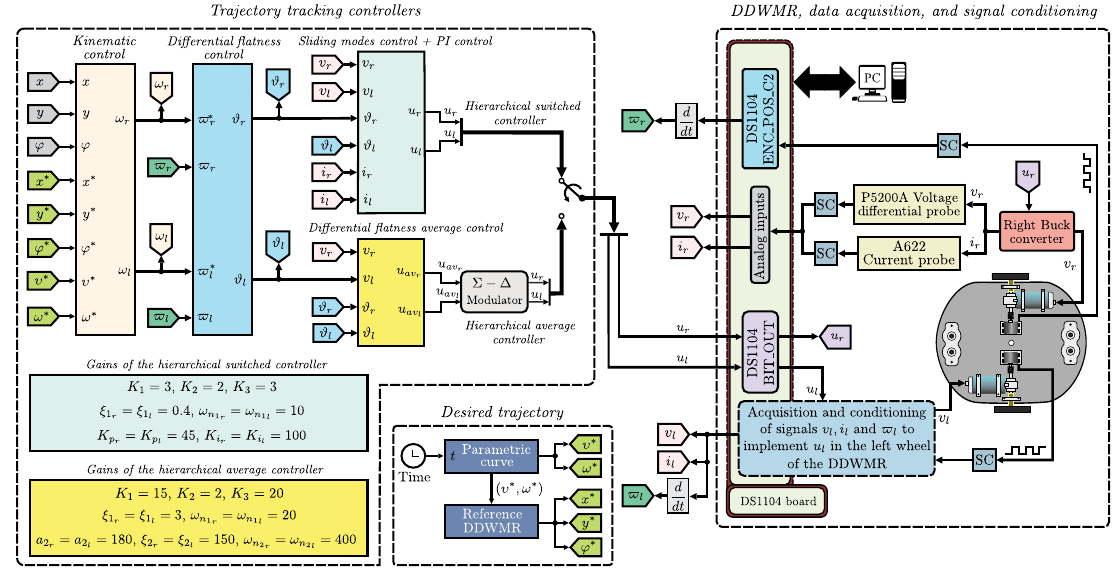
Figure 4. Connections diagram of the DDWMR in closed-loop.